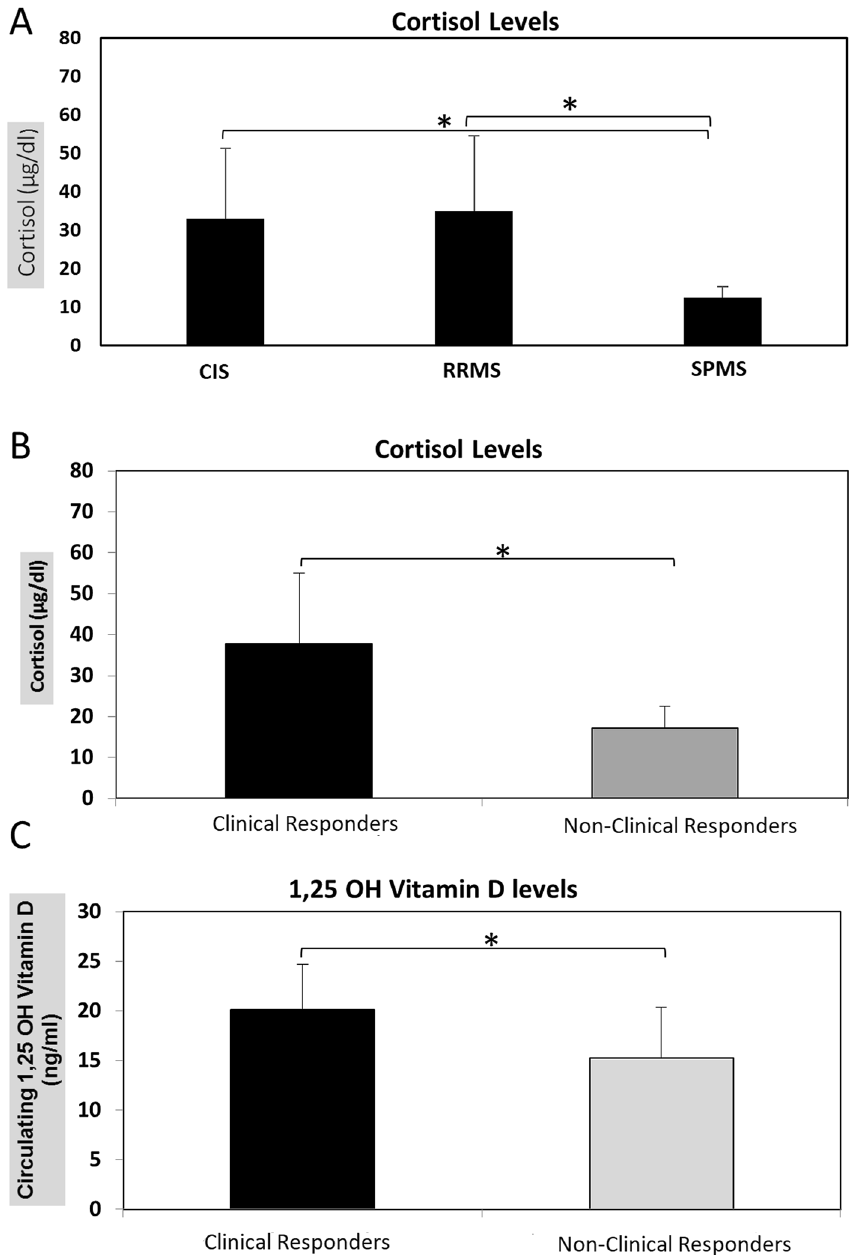
Figure 2. Serum Cortisol (μg/dl) and 1,25 OH Vitamin D levels (ng/ml) in MS patients 1 h before the 1st MP treatment. ( A ) Cortisol levels were significantly higher in CIS and RRMS as compared to SPMS patients ( p < 0.05). ( B ) Cortisol levels is significantly higher in clinical responders as compared to non-clinical responders ( p < 0.05). ( C ) The 1,25-Dihydroxyvitamin D levels are significantly higher in clinical responders as compared to non-clinical responders ( p <